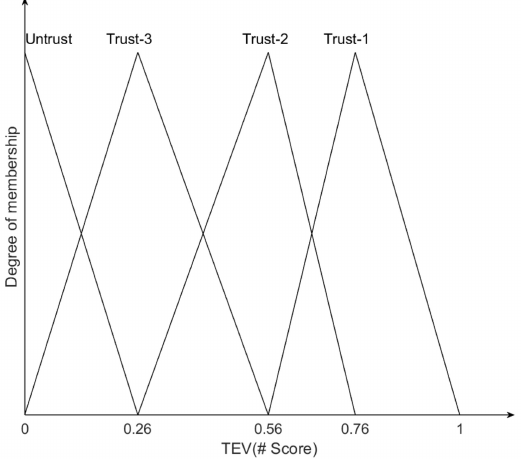
Figure 4. The output membership function of